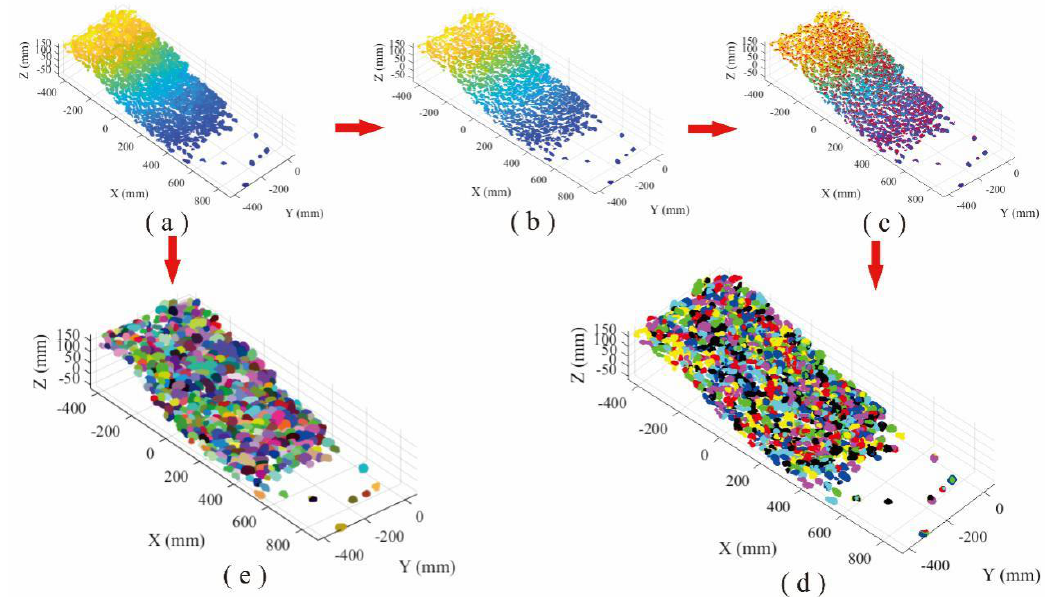
Figure 12. Comparison of recognition performance of mixed material loose accumulation: ( a ) point cloud, ( b ) separation processing, ( c ) peak points of each block region, ( d ) recognition using HC-RG algorithm, and ( e ) recognition using AS algorithm.